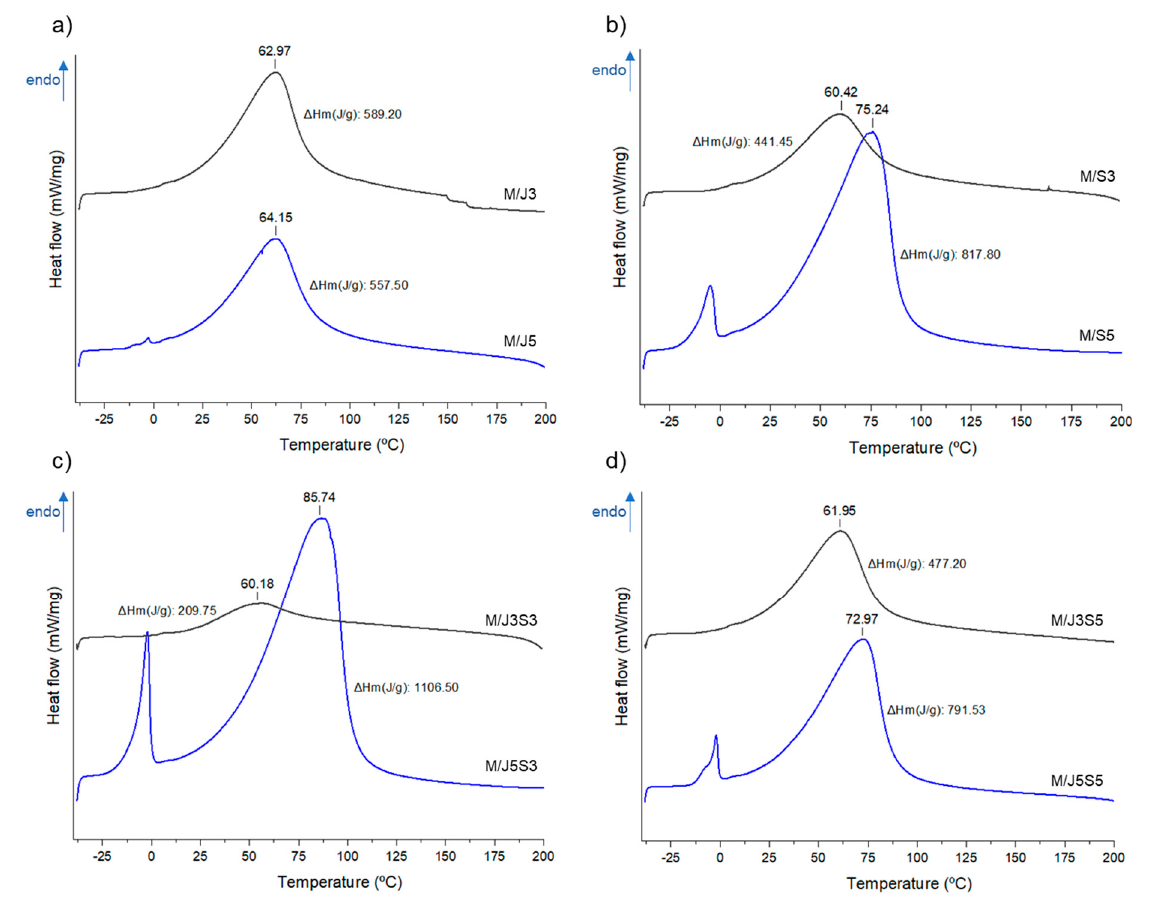
Figure 9. Differential scanning calorimetry (DSC) thermograms of the developed polymeric mem- branes M/J3 to M/J5S5 experiencing controlled heating from -40 to 200 °C: ( a ) M/J3 and M/J5; ( b ) M/S3 and M/S5; ( c ) M/J3S3 and M/J5S3 and ( d ) M/J3S5 and M/J5S5.